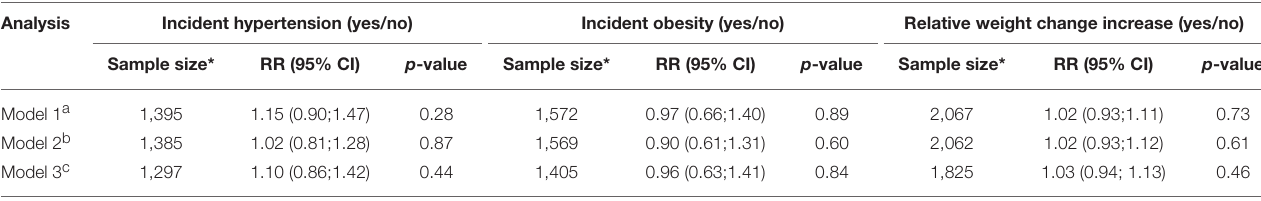
TABLE 4 | Association of H. pylori seropositivity with incident hypertension, obesity, and relative weight change increase.